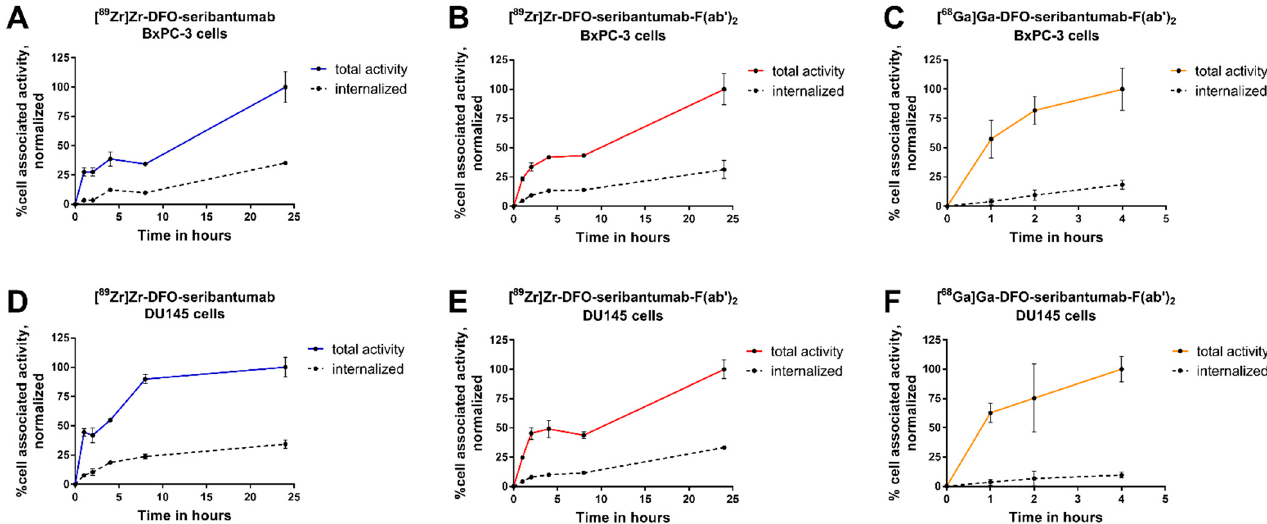
Figure 2. Cellular uptake and internalization of [ 89 Zr]Zr-DFO-seribantumab ( A , D ), [ 89 Zr]Zr-DFO-seribantumab-F(ab’) 2 ( B , E ), and [ 68 Ga]Ga-DFO-seribantumab-F(ab’) 2 ( C , F ) in BxPC-3 ( A – C ) and DU145 cells ( D – F ). Data were normalized to the maximum total uptake and are presented as the average of three dishes ( n = 3) with SD. Cells were continuously incubated with the radioconjugates at 37 °C. At selected time points, a set of dishes was removed from the incubator and membrane bound and internalized activity were collected. Data on the uptake and internalization of [ 68 Ga]Ga-ZHER3 can be found in [27].